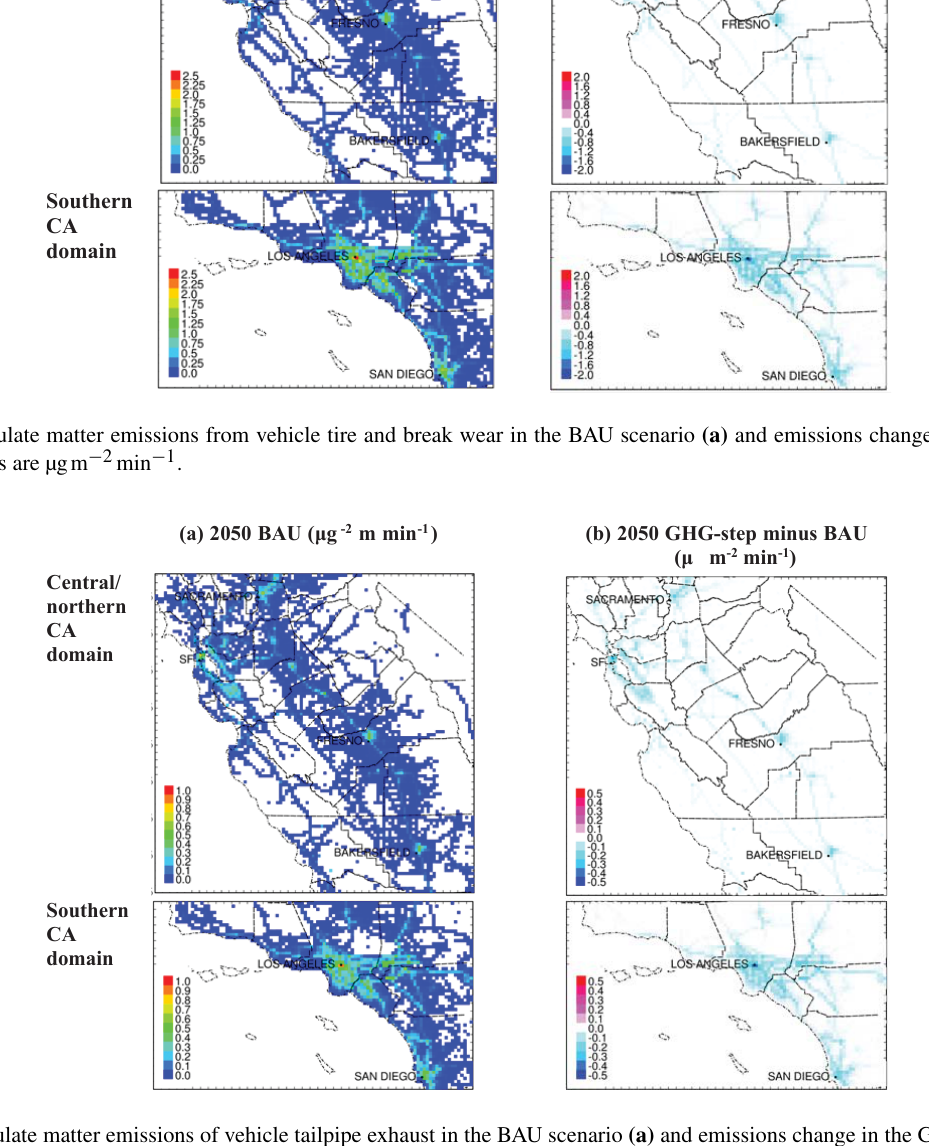
Figure 12. Particulate matter emissions of vehicle tailpipe exhaust in the BAU scenario (a) and emissions change in the GHG-Step scenario (b) . Units are µgm − 2 min − 1